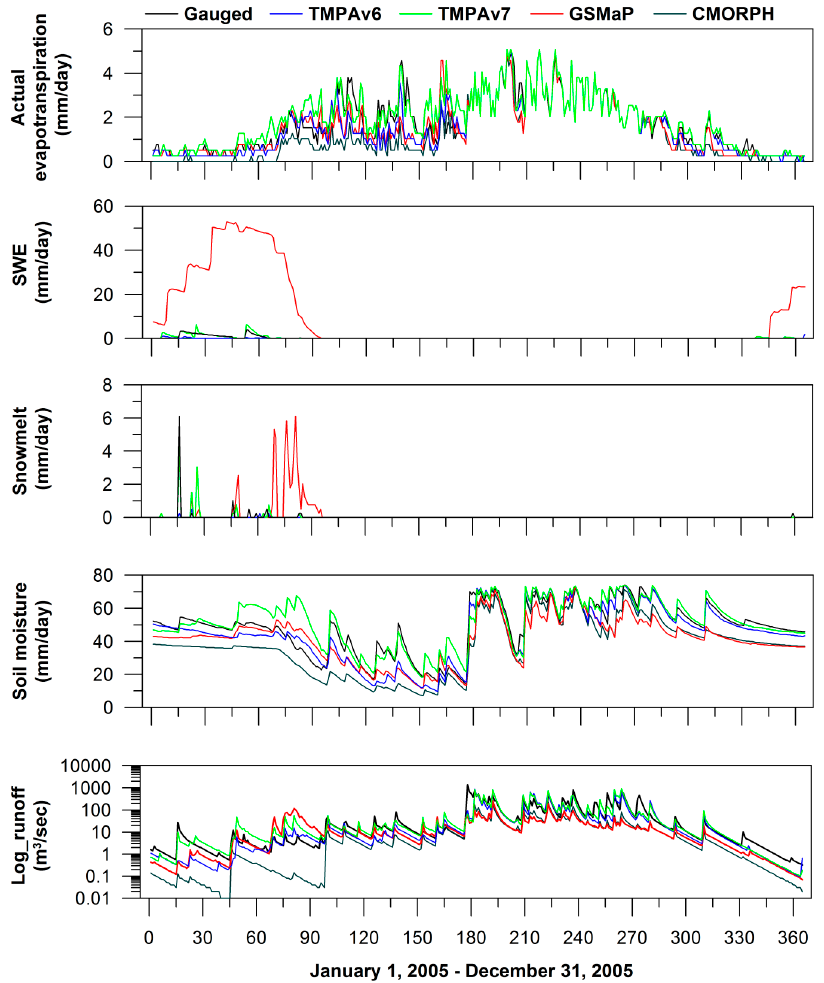
Figure 7. Estimated AET, SWE, snowmelt, soil moisture, and runoff by the PRMS hydrologic model using gauged precipitation and four satellite-derived precipitation products in 2005.